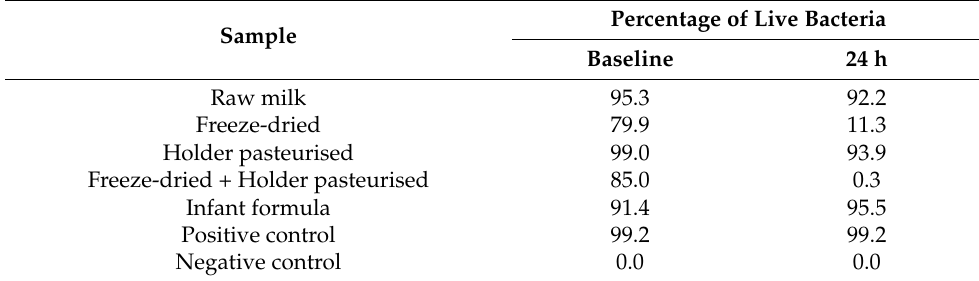
Table 1. Percentage of live and dead S. aureus detected by flow cytometry. Live bacteria detected with SYTO9 and dead bacteria detected by DAPI. Measurements taken immediately after inoculation and 24 hours after